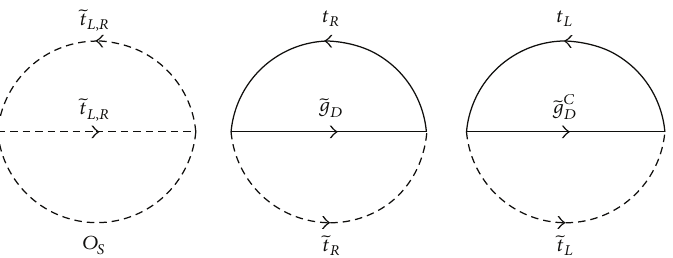
Figure 4: Two-loop diagrams contributing to the Higgs boson mass via (6) which depend on the Dirac mass 𝑀 𝐷 𝑂 and the soft sgluon mass 𝑚 𝑂 . We only draw diagrams involving top/stop; similar diagrams exist for all quark/squark